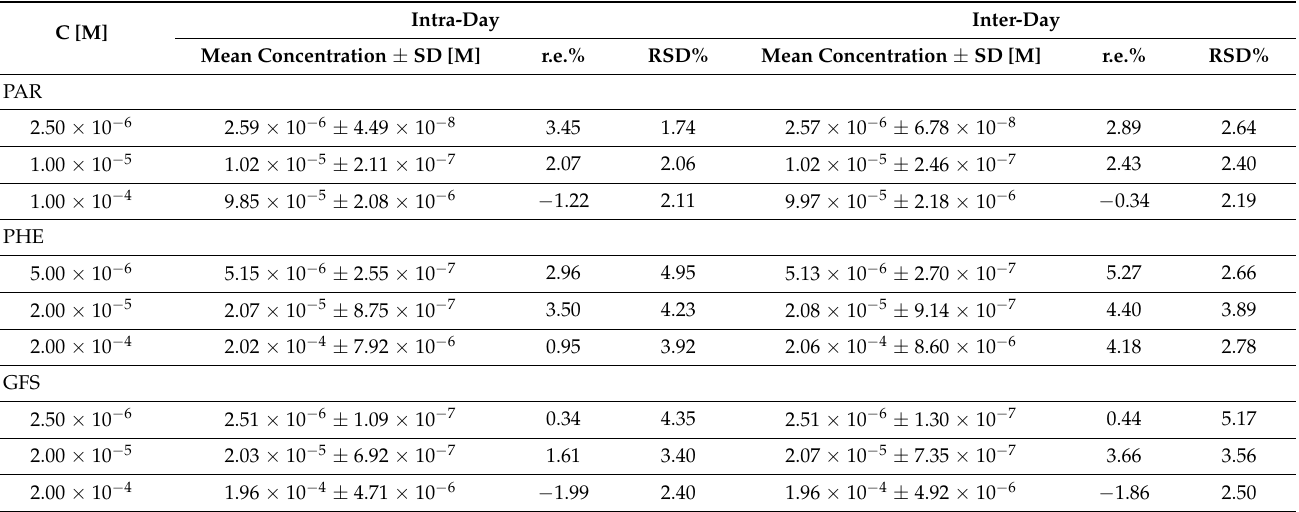
Table 1. Accuracy and precision data of DPV method for PAR, PHE and GFS quantification; SD— standard deviation.